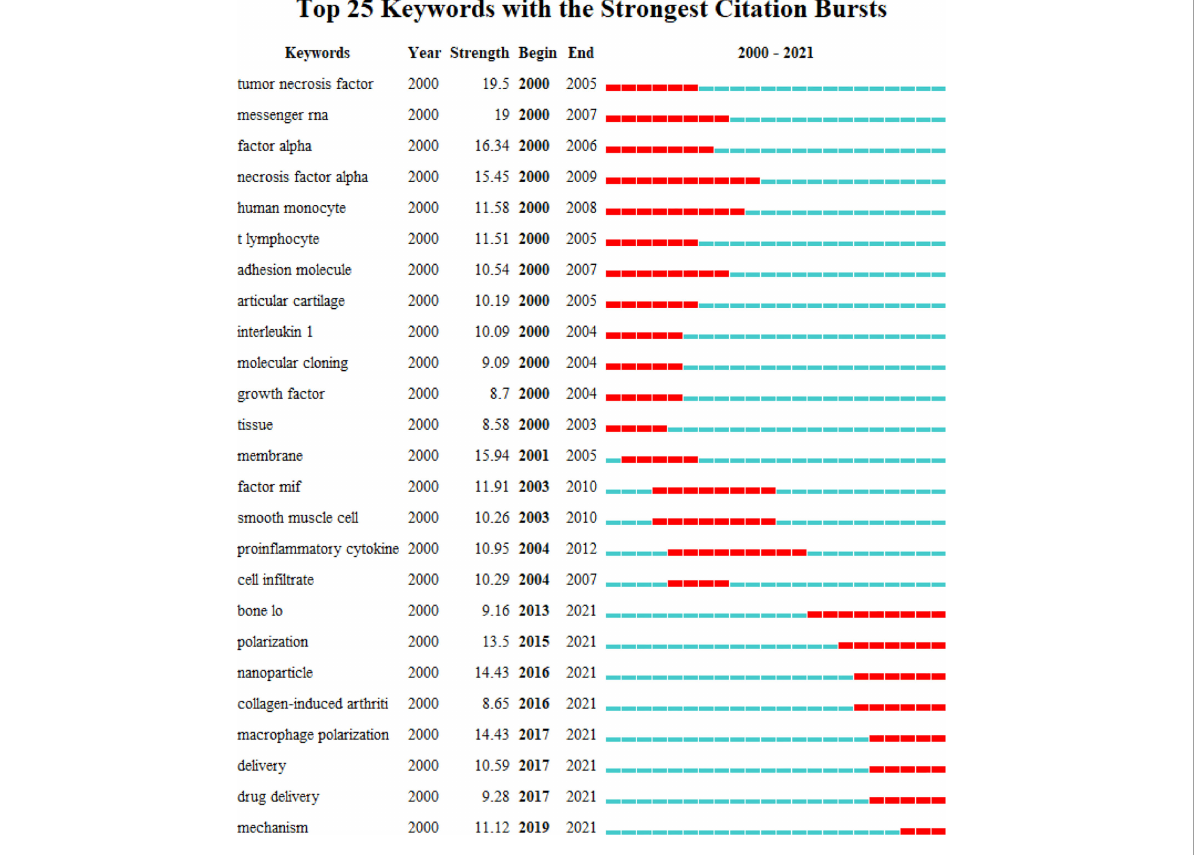
FIGURE 7 CiteSpace visualization map of top 25 keywords with the strongest citation bursts involved in macrophage-related